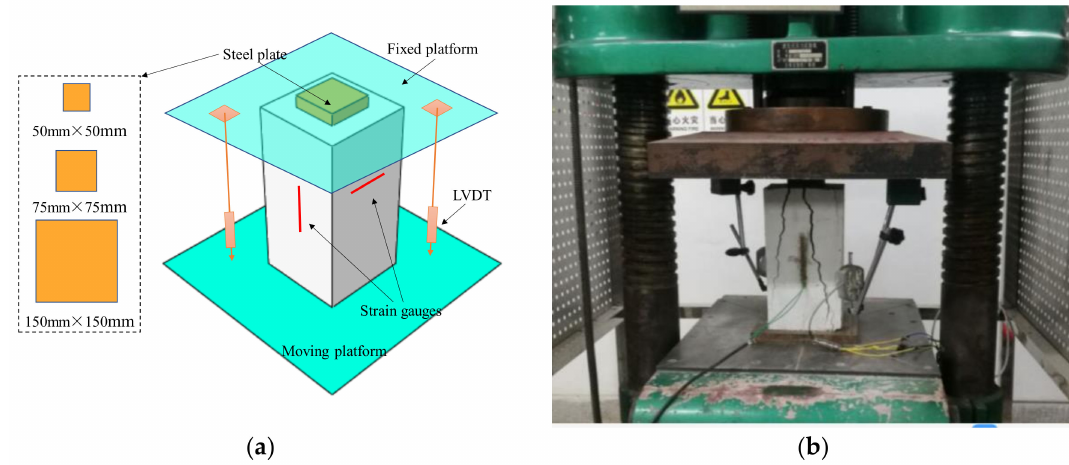
Figure 5. Schematic diagram of partial-contact-loading test setup: ( a ) schematic diagram; ( b ) photo. LVDT, linear variable displacement transformer.